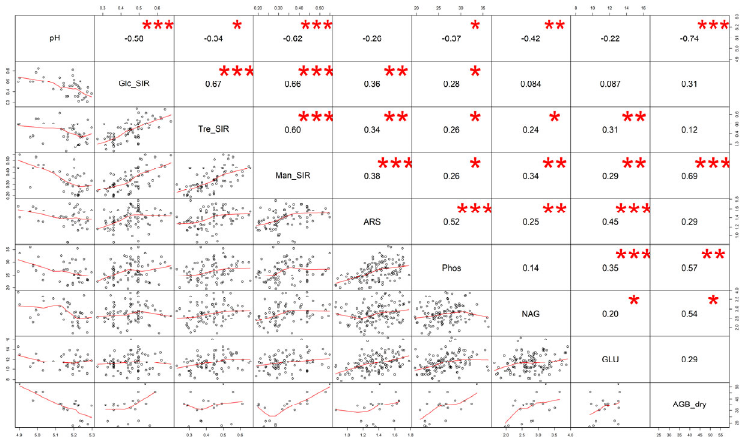
Figure A2. Pearson’s correlation matrix of properties determined in the experiment. The asterisks indicate a level of significance of statistical difference between the variables: * for p ≤ 0.05, ** for p ≤ 0.01, *** for p ≤ 0.001.